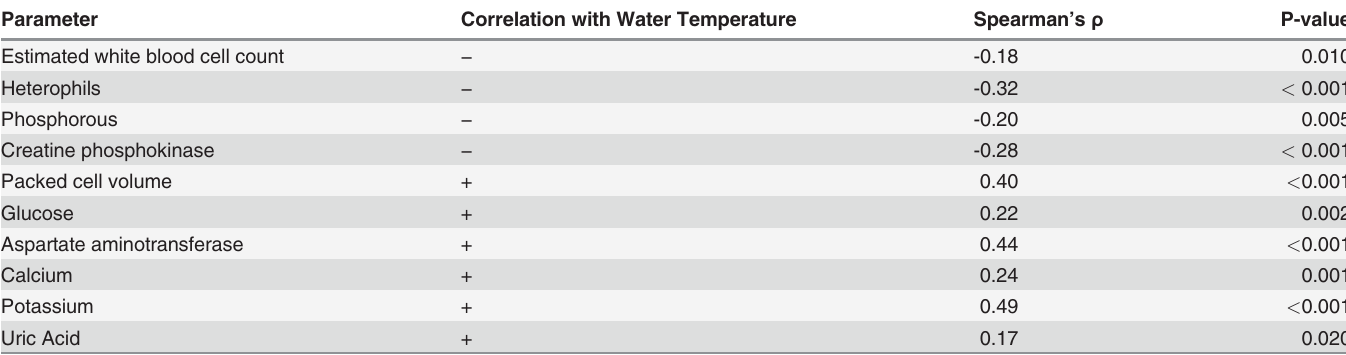
Table 3. Hematology and plasma biochemical parameters that were signi fi cantly correlated with water temperature in juvenile loggerhead sea turtles ( Caretta caretta ) sampled in Core Sound, North Carolina,